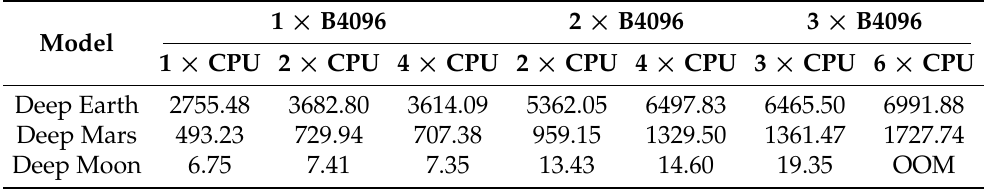
Table 11. Offline benchmark results (throughput in samples per second) for B4096 DPU